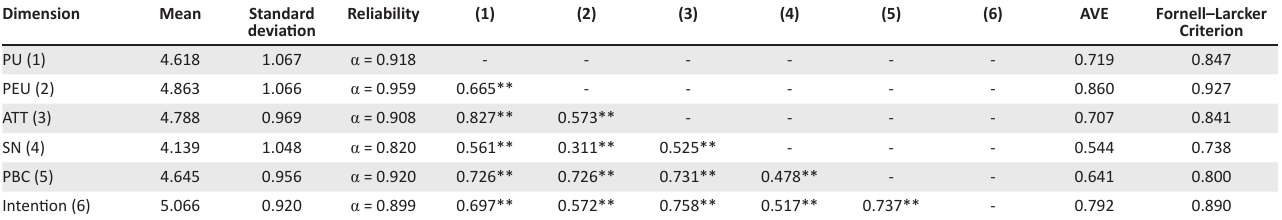
TABLE 4: Descriptive, reliability and correlation statistics.